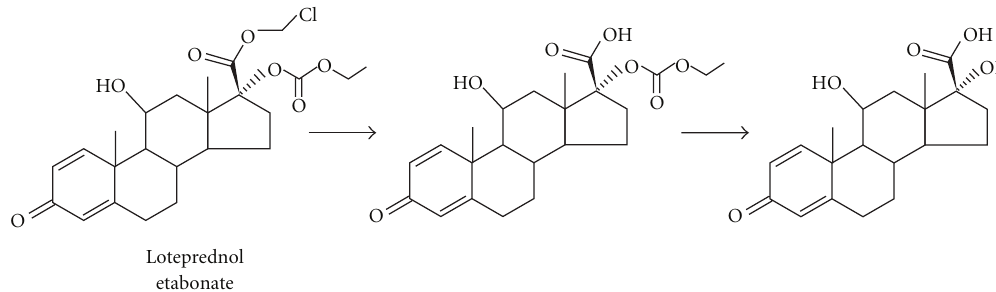
Figure 4: Metabolism of loteprednol